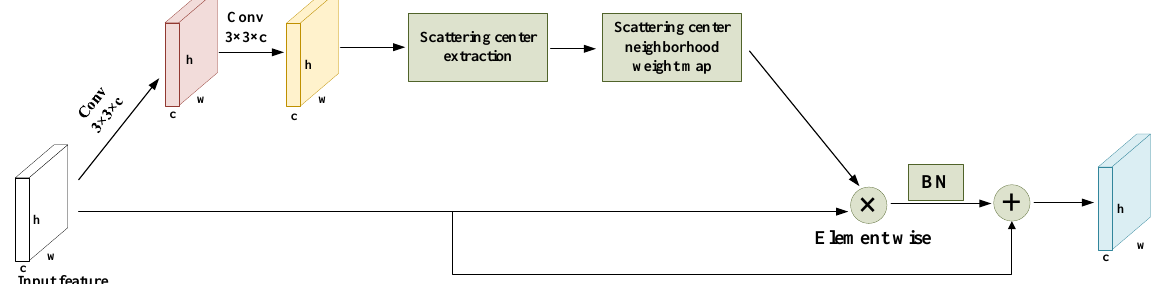
Figure 15. The improved structure for the ICB